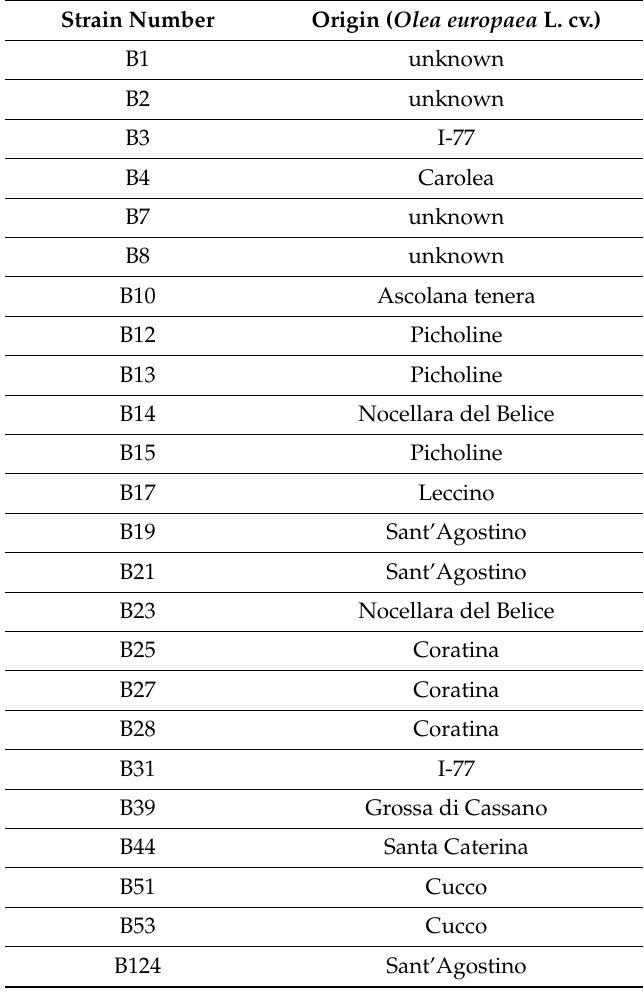
Table 1. Bacterial strains and plant origin of the fermenting brines. Strain Number Origin ( Olea europaea L.